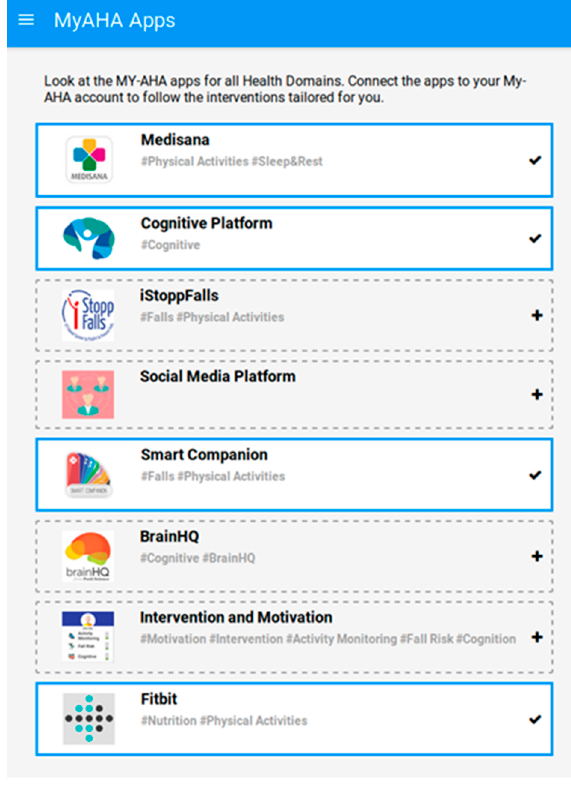
Figure 7. My-AHA apps interface.